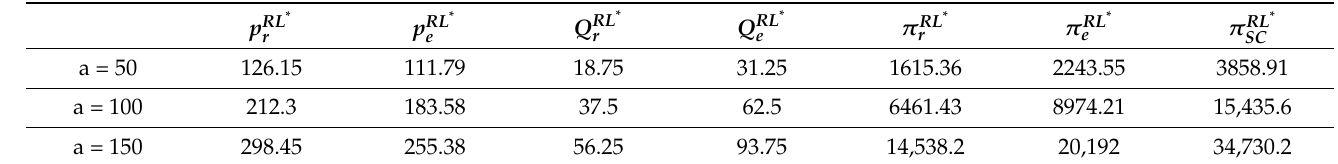
Table 2. Optimal decisions of channel members under the RL game—Case 1.